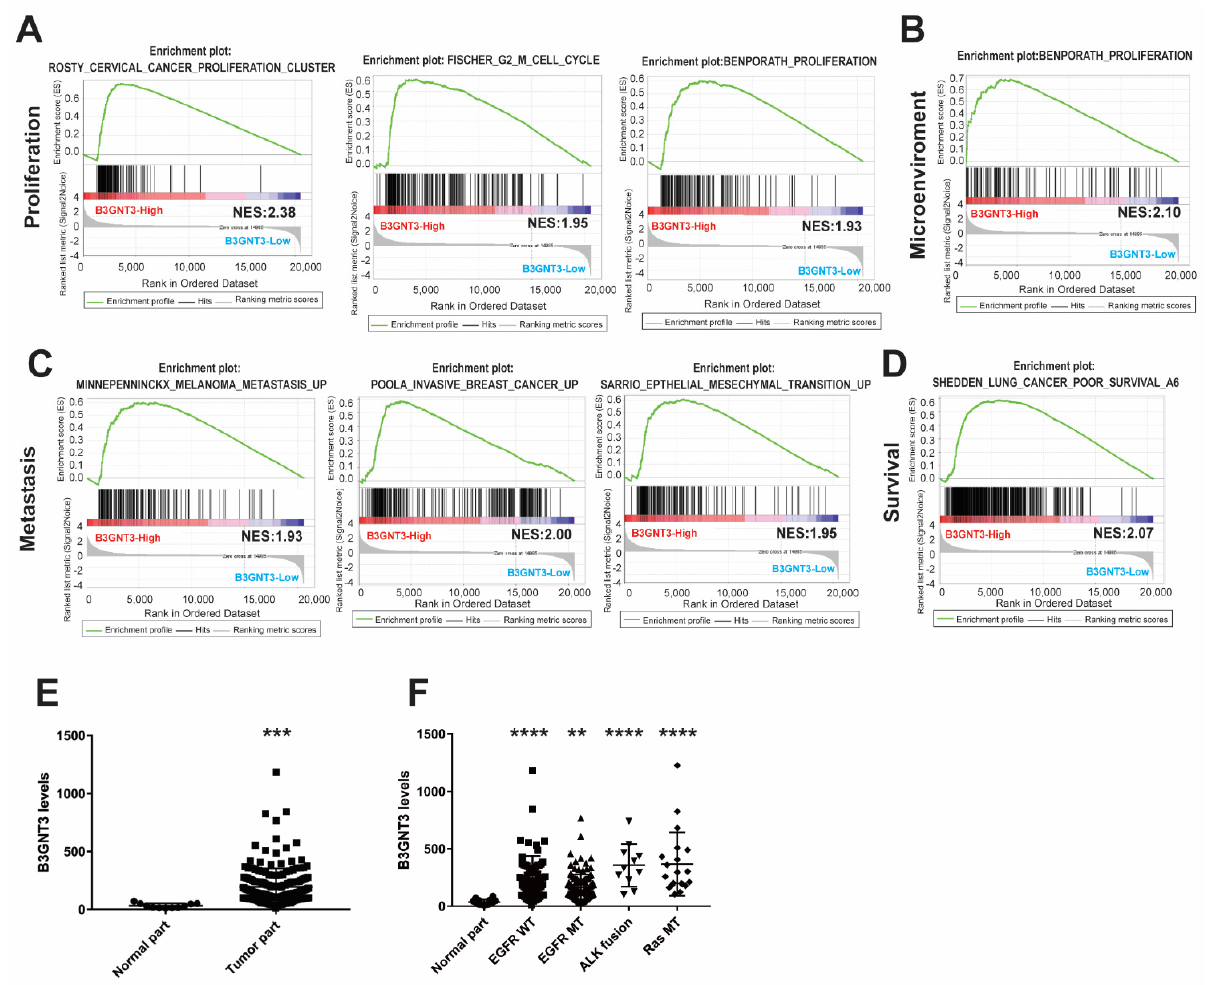
Figure 6. Functional status of B3GNT3 in LUAD and its correlation with targetable mutated genes. ( A ) B3GNT3 expression is positive correlated with cell proliferation, cell cycle and the tumor microenvironment ( B ), tumor metastasis ( C ), and poor prognosis ( D ) based on GSEA. ( E ) B3GNT3 expression in tumor and normal parts of LUAD from GSE31210 dataset. ( F ) The expression of B3GNT3 in normal tissues and in tumors without epithelial growth factor receptor mutation (EGFR WT), with EGFR mutation (EGFR MT), ALK fusion (ALK fusion), and KRAS mutation (RAS MT) are listed, taken from the GSE31210 dataset. (**, p < 0.01; ***, p < 0.005; ****, p < 0.001).